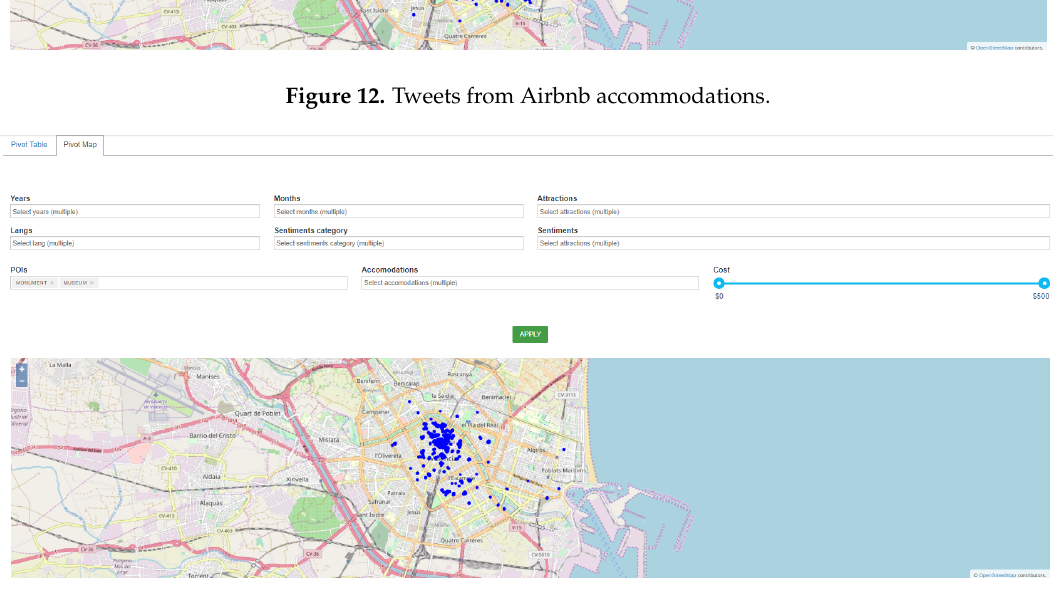
Figure 13. Tweets from museums and